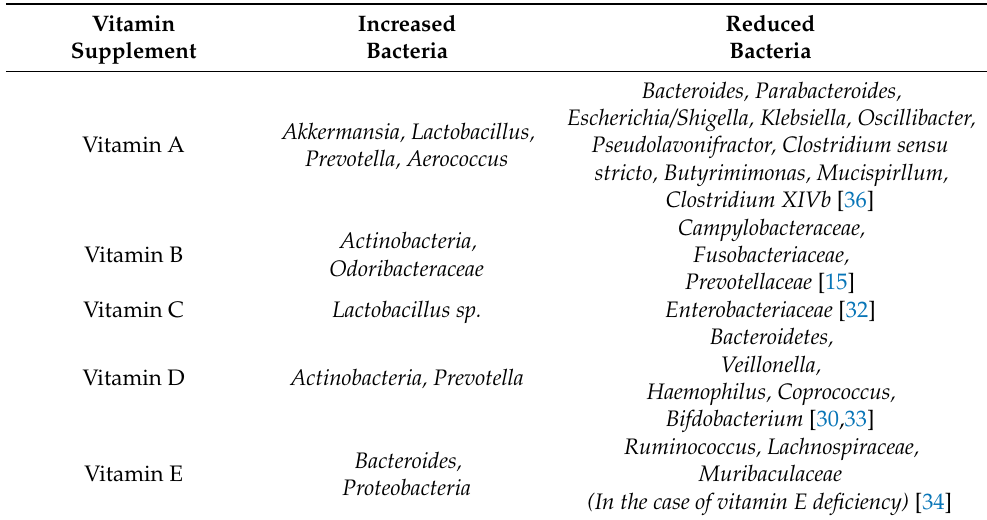
Table 1. Effects of vitamin supplementation on the human gut microbiota. The table is modified according to: